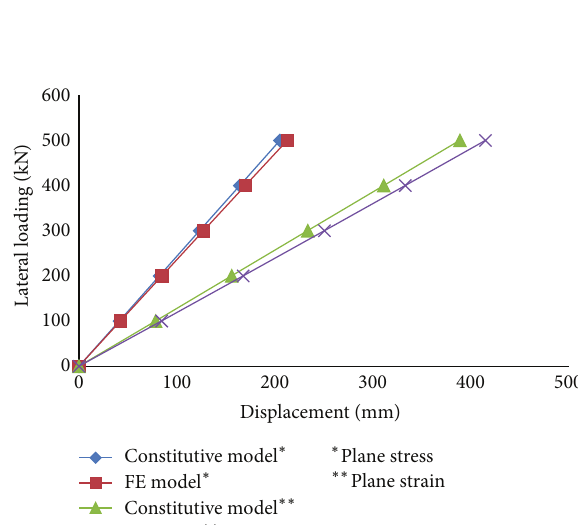
Figure 10: Three concrete segments’ model (RC3SS).